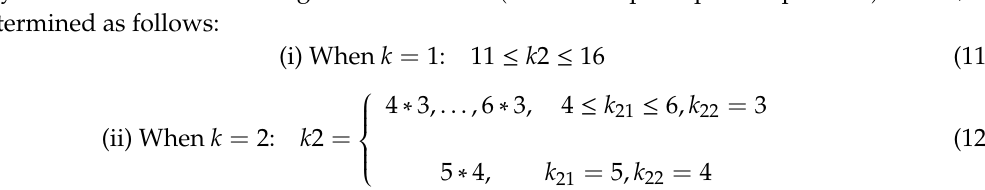
Table 4. Different values of 𝑘1 .